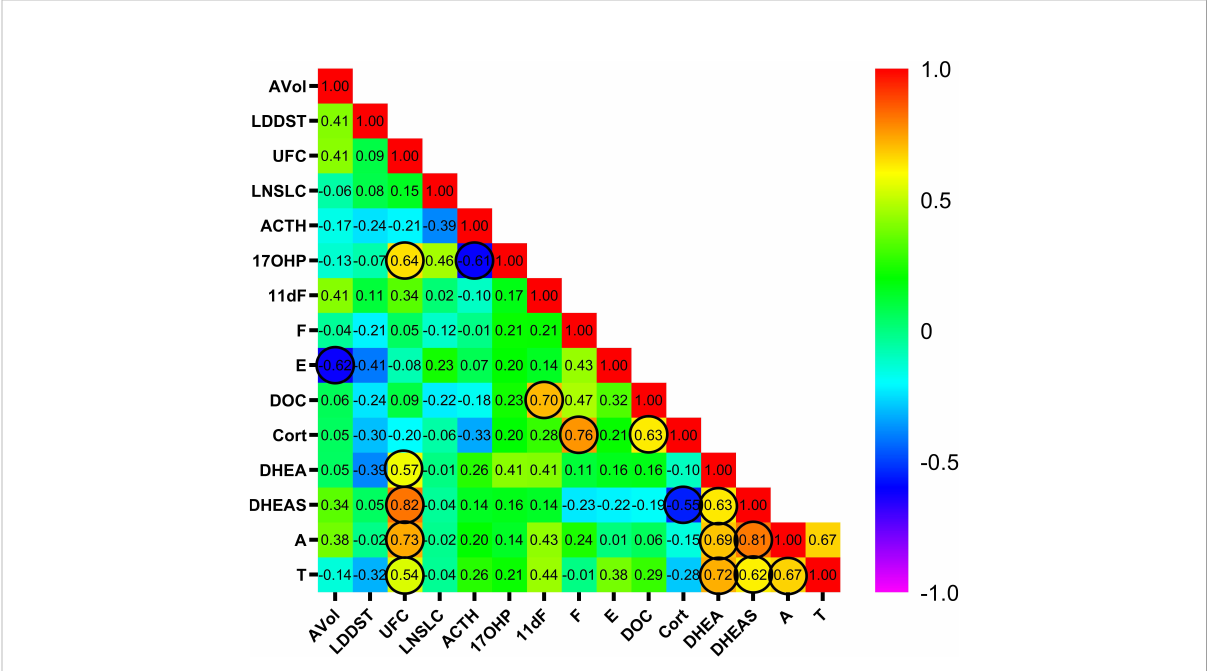
FIGURE 1 Correlation between adrenal volume, the three diagnostic tests of hypercortisolism, and peripheral steroid concentrations as measured by LC-LC/MS. The values in cells are the coef fi cient r, the circles indicate statistical signi fi cance ( p <0.05). Male and premenopausal female patients were excluded. AVol: adrenal volume; UFC, 24h urinary free cortisol; LDDST, low dose dexamethasone suppression test; LNSLC, late-night salivary cortisol; late-night salivary cortisol; ACTH, adrenocorticotropic hormone. 17OHP, 17-hydroxyprogesterone; 11dF, 11-deoxycortisol; F, cortisol; E, cortisone; DOC, 11-deoxycorticosterone; Cort, corticosterone; DHEA, dehydroepiandrosterone; DHEAS, dehydroepiandrosterone sulfate; A, androstenedione; T,